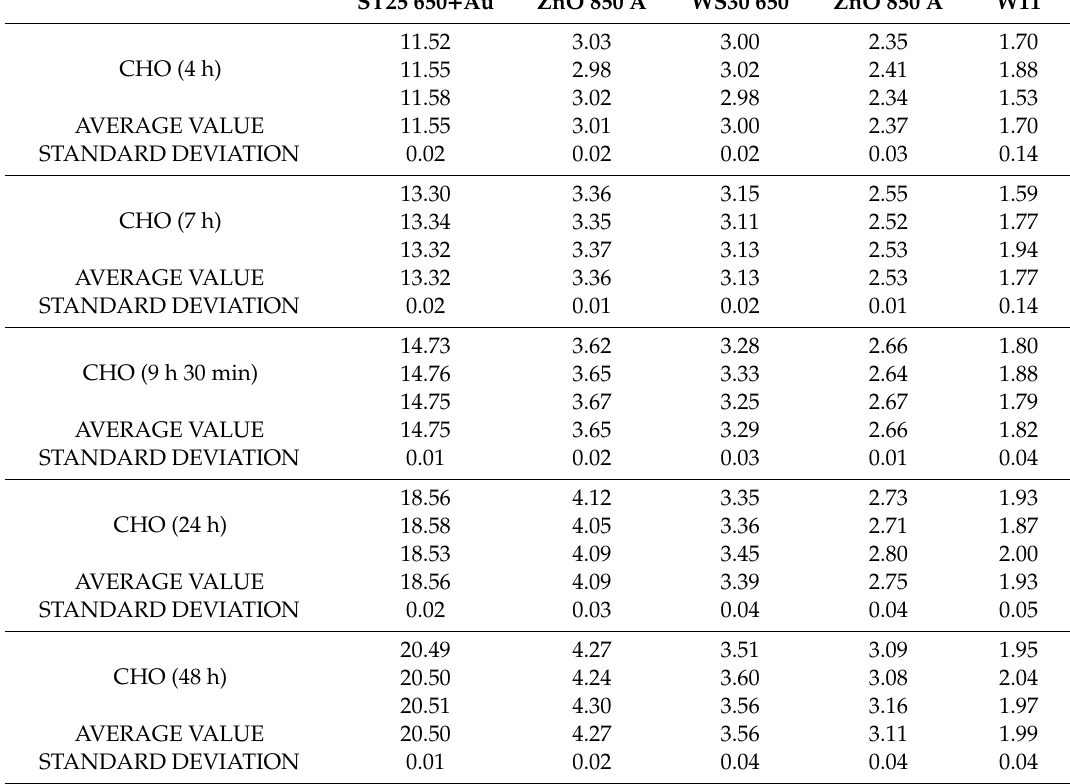
Figure 1. Test results from ST25 650+Au, ST20 650, SnO2, ZnO 850, and SnS2 sensors on the Dulbecco’s modified Eagle’s medium (DMEM) breeding ground, fibroblasts, and human embryo kidney cell (HEK-293) samples, incubated for the same time (48 h). Table 3. Data, average values, and standard deviations from cell cultures tests shown in Figure 1.